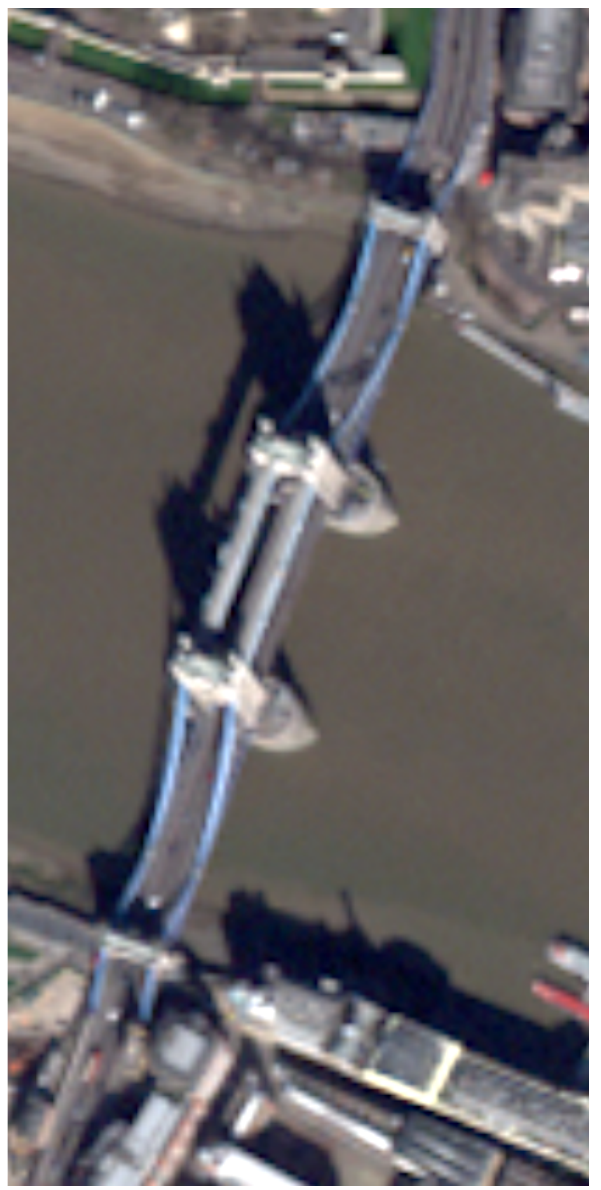
Figure 3 : MS image up-sampled to Pan resolution using bilinear resampling.